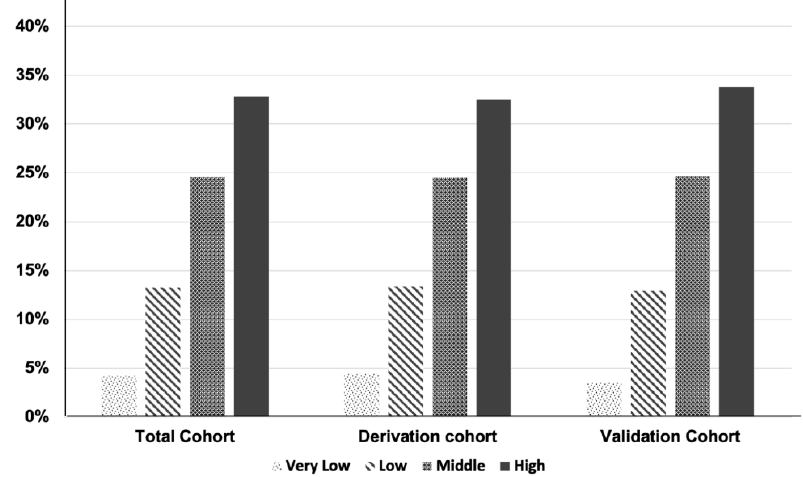
Figure 2. Thirty-day surgical mortality rates in the derivation and validation groups were categorized by surgery for acute mesenteric infarction mortality score (SAMIMS). Very low risk, SAMIMS = 0; low risk, SAMIMS = 1 – 3; intermediate risk, SAMIMS = 4 – 6; high risk, SAMIMS = 7 – 13). Table 3. Risk of 30-day mortality in the derivation and validation groups .